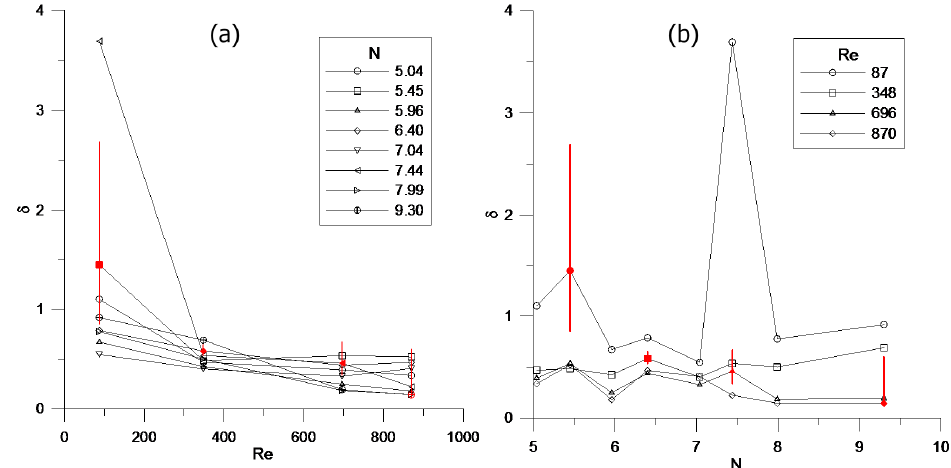
Figure 14. Variation of parameter δ against ( a ) Re for all values of N ; and ( b ) N for all values of Re.